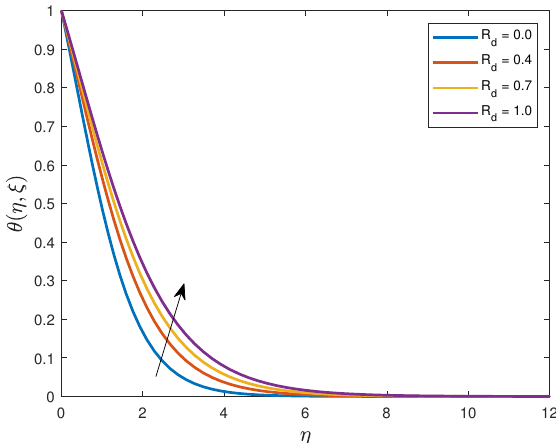
Figure 23. The influence of R d on fluid temperature.